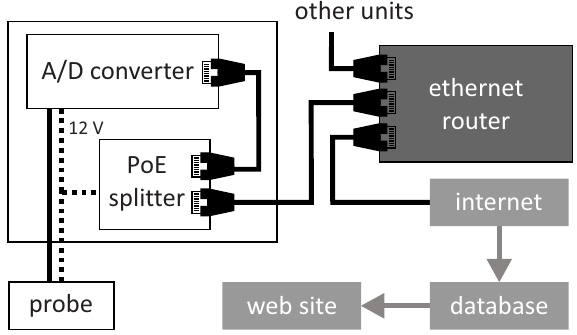
Fig. 6. Configuration of electric and data collection network, with an example of one measuring point.